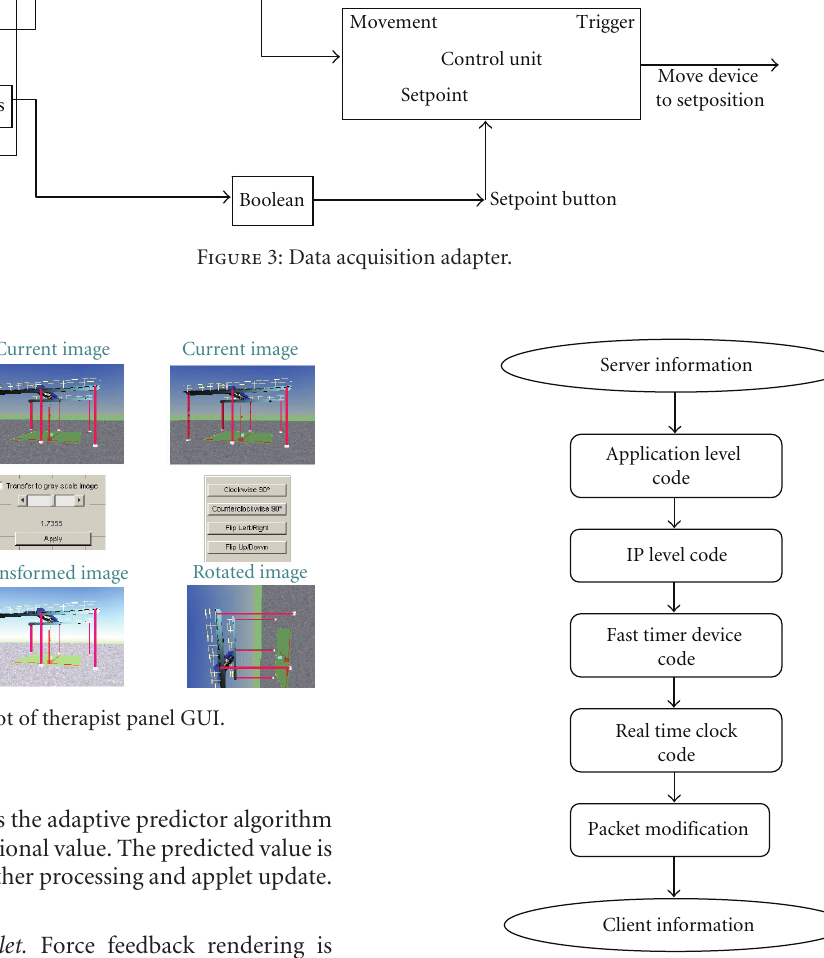
Figure 5: NISTNet